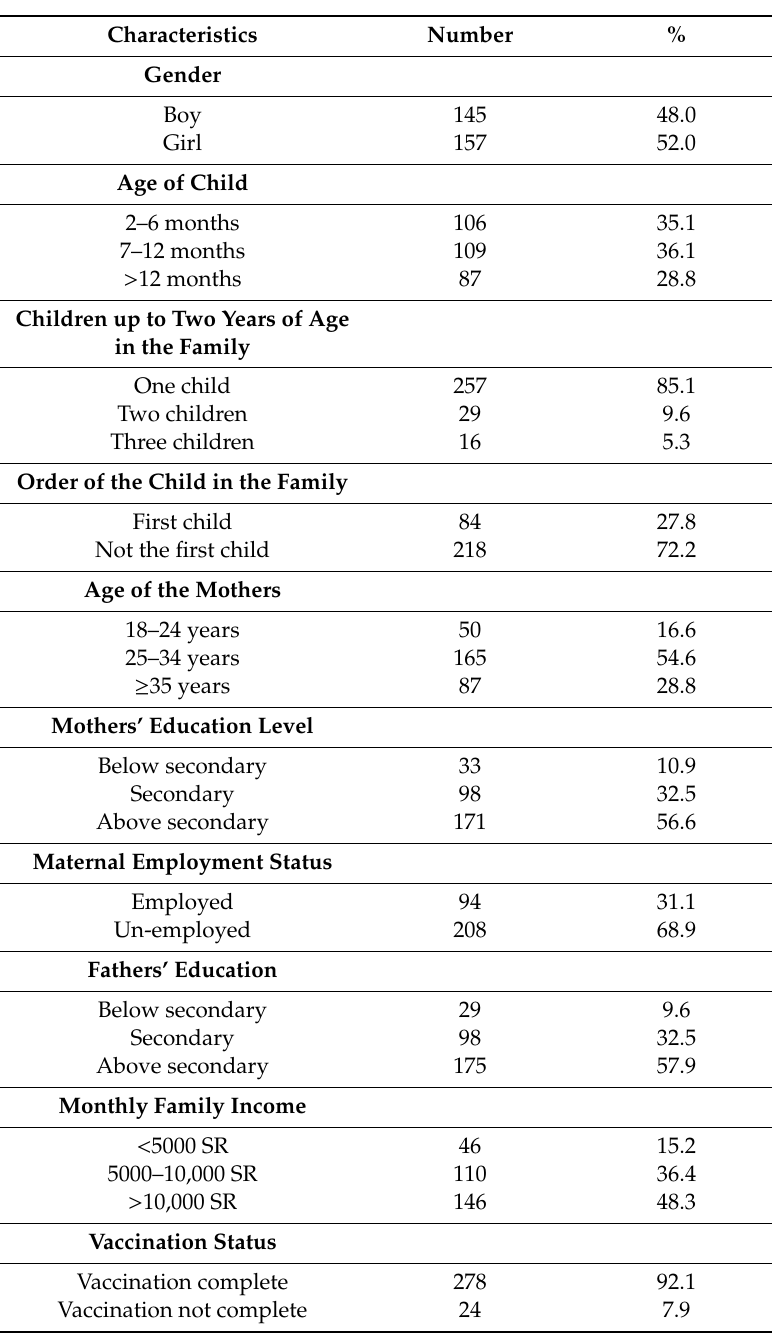
Table 1. Background characteristics of the